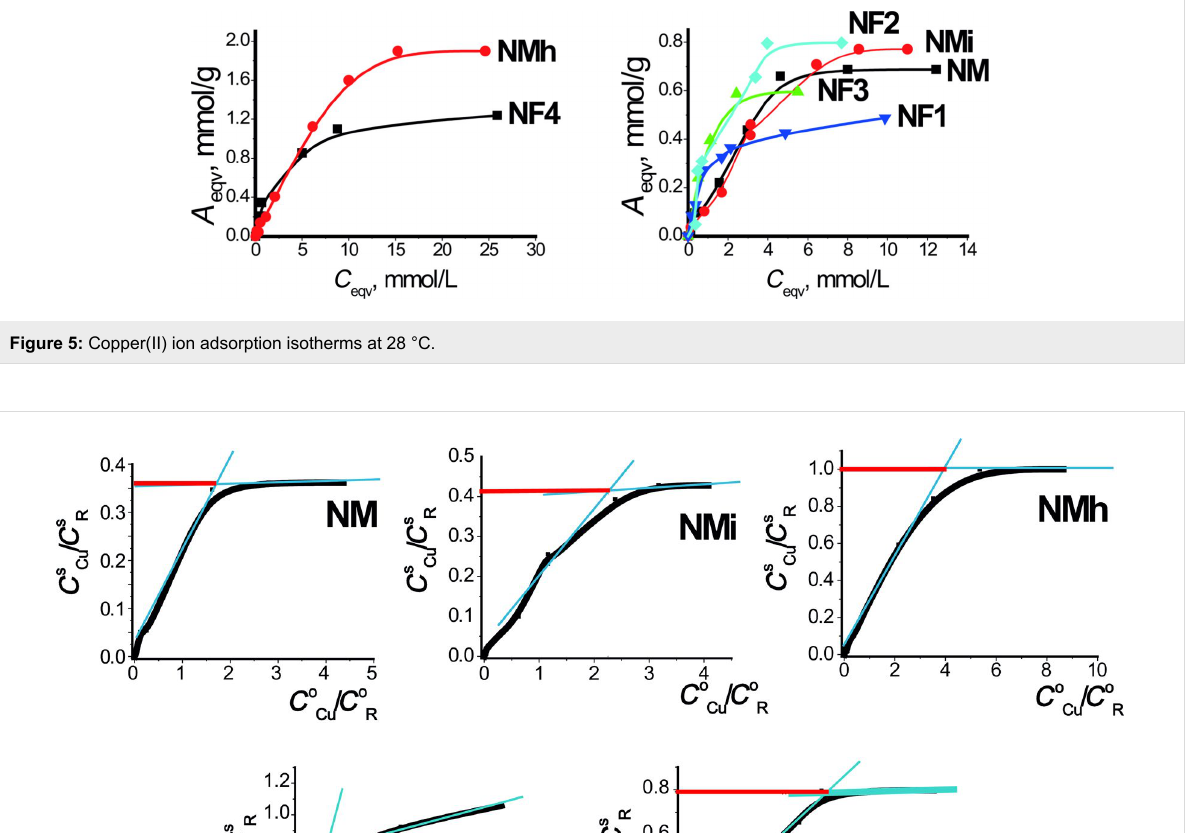
tional samples, where the equilibrium is reached within 30